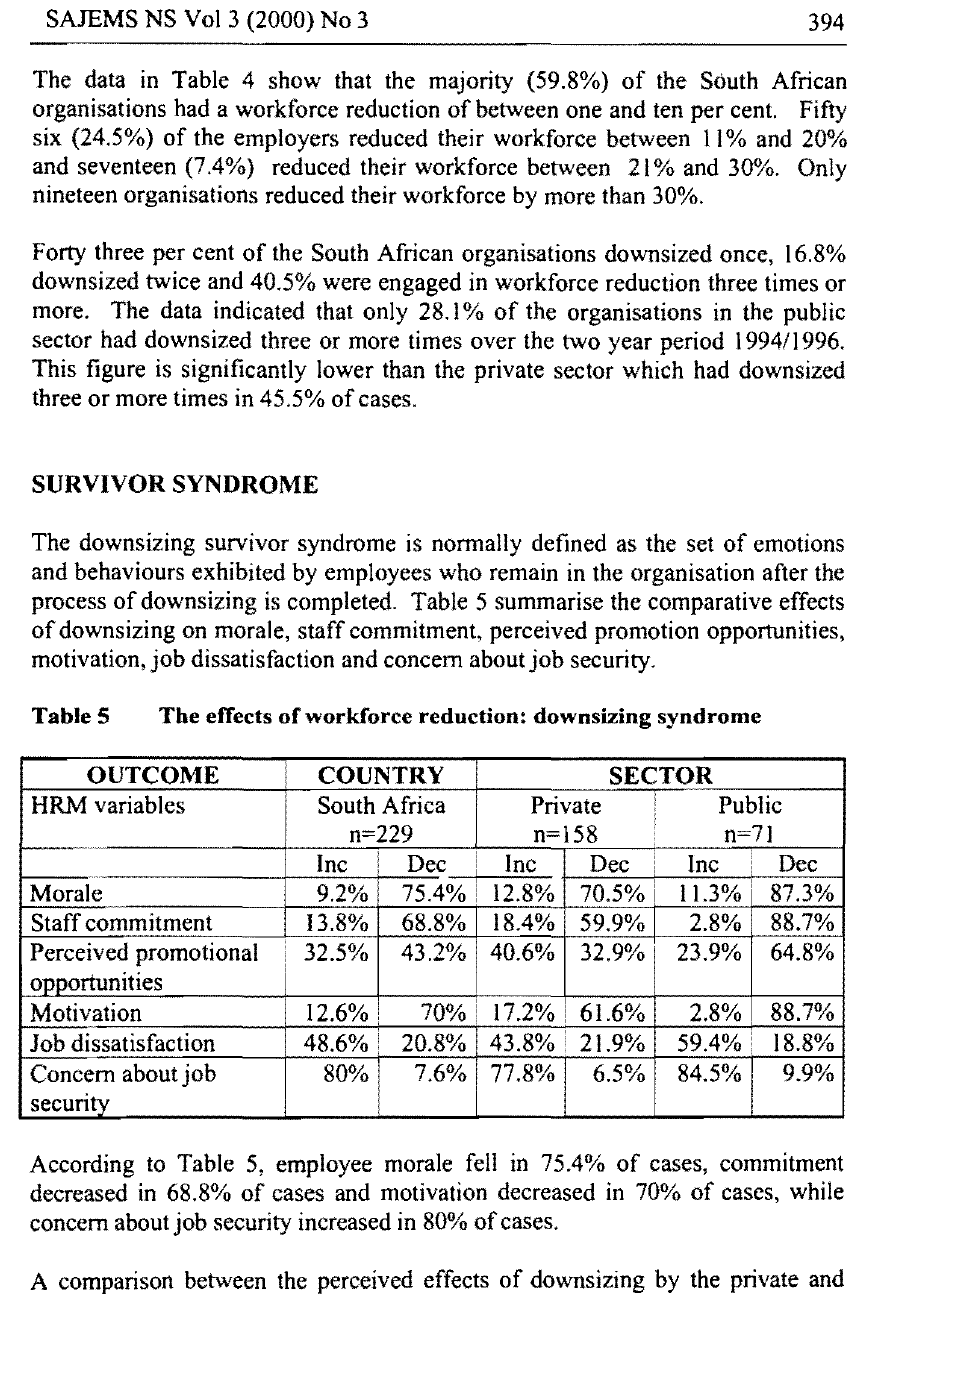
The effects of workforce reduction: downsizing